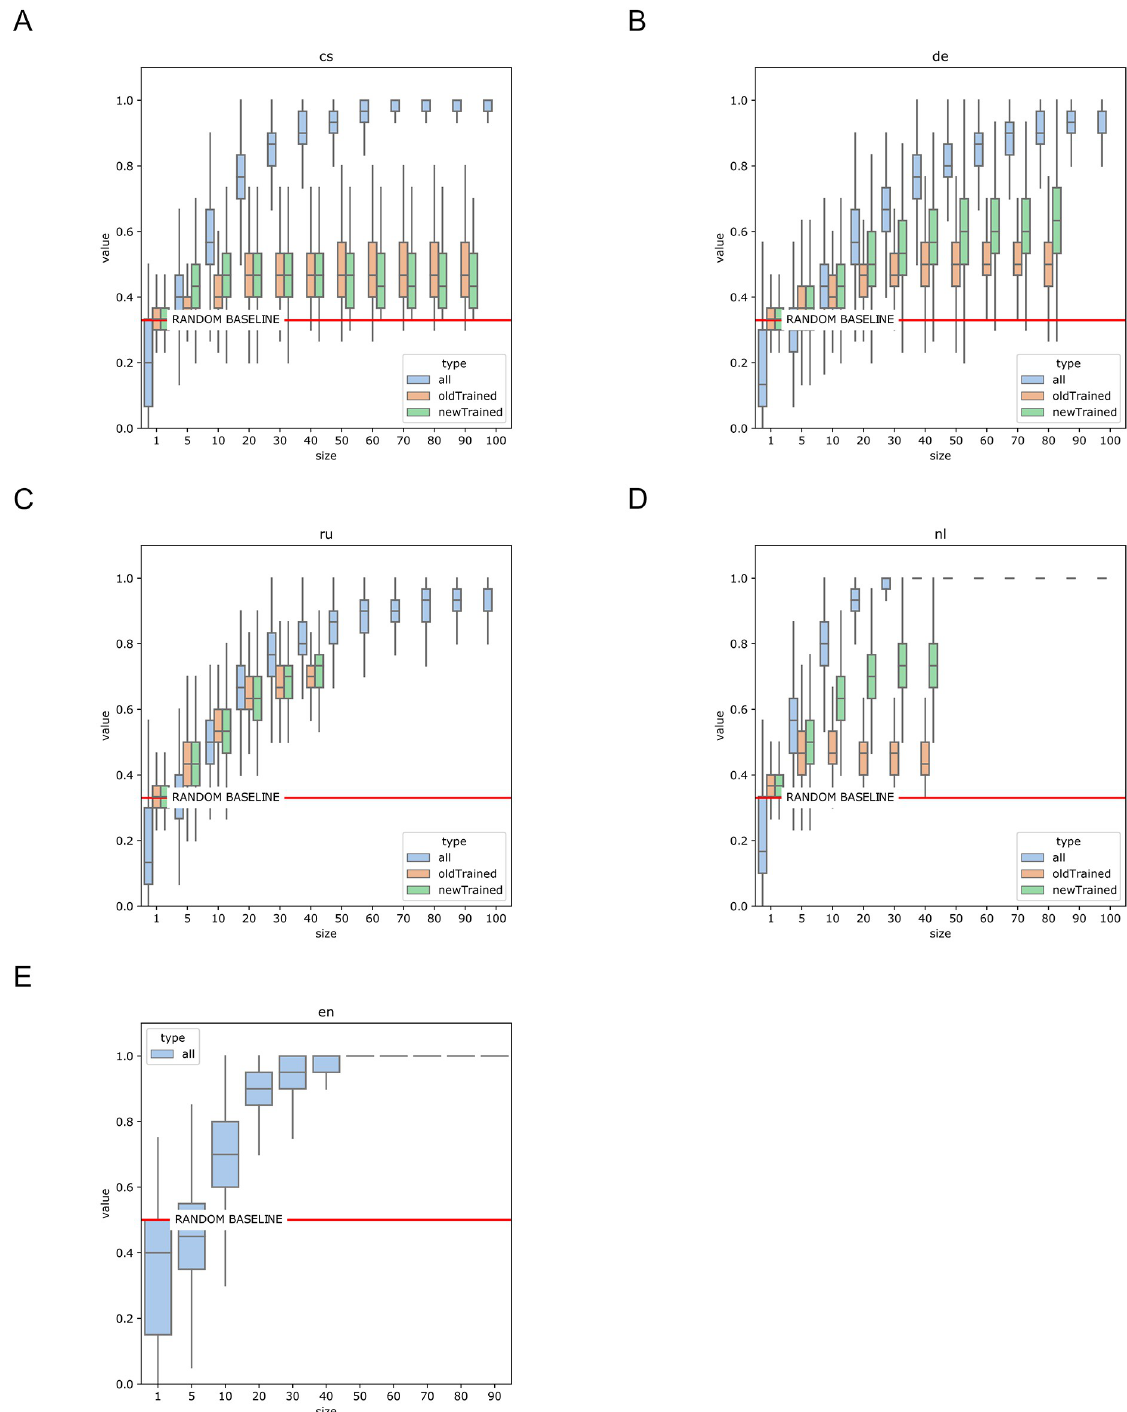
Fig 2. Accuracy of SVM classifications. Predicting meter with vectors defined by topic probabilities in random samples of poems (sample size 2 {1, 5} [ {10, 20, ... , 100}). (1) trained and tested on the entire dataset (leave-one-out cross-validation), (2) trained on earlier data and tested on later data, (3) trained on later data and tested on earlier data. 10,000 iterations. (A) Czech, (B) German, (C) Russian, (D) Dutch, (E) English.